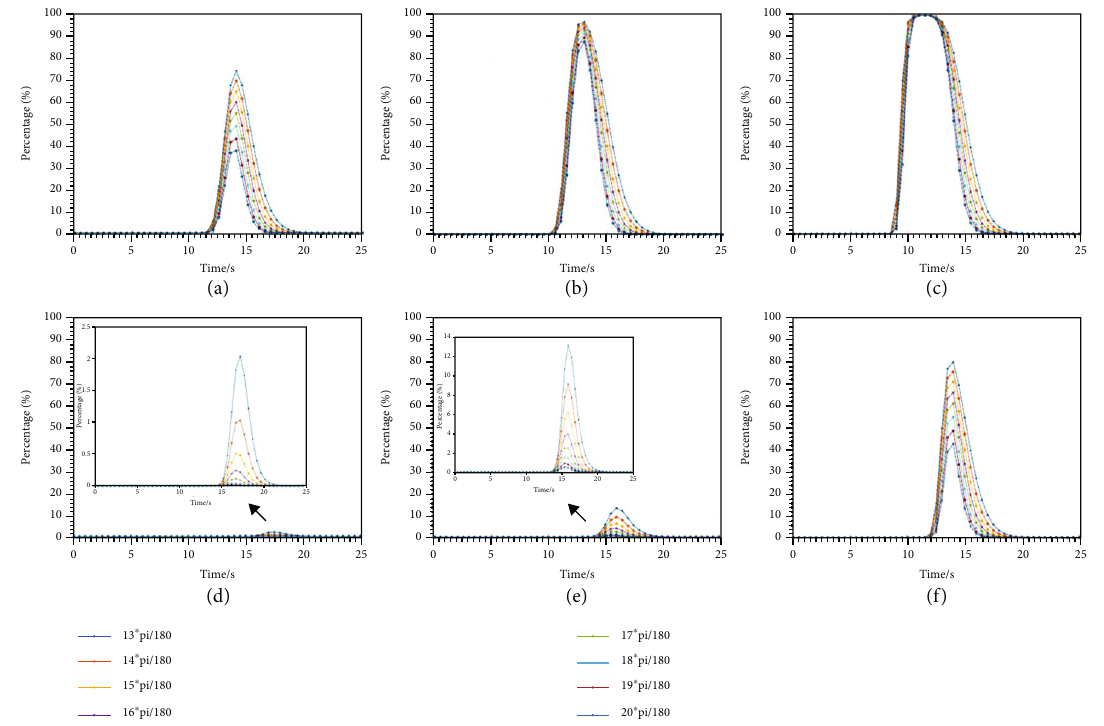
Figure 12: Con fl ict risk assessment of constant airspeed climb (MAV and UAV climbing at the same θ 1000-4200 m) versus H = 0 , V over 1000 simulations. (a) d = 3 × 10 3 , θ = π /6 ; (b) d = 3 × 10 3 , θ = π /3 ; (c) d = 3 × 10 3 , θ = π /2 ; (d) d = 3 : 5 × 10 3 , θ = π /6 ; (e) d = 3 : 5 × 10 3 , θ = π /3 ; (f) d = 3 : 5 × 10 3 , θ = π /2 .